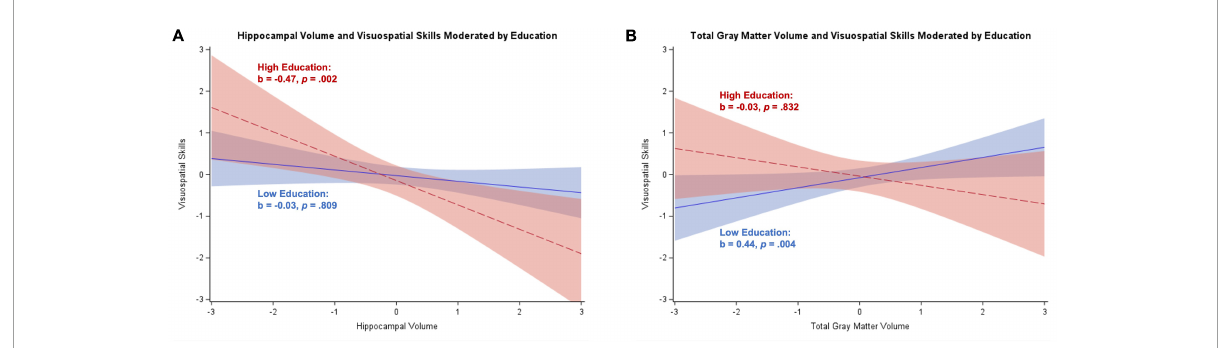
FIGURE2 Plots of significant moderations by education of the associations between brain volume and visuospatial skills for participants with dementia. High education corresponds to 1 SD above the mean and low education corresponds to 1 SD below the mean. The red dotted line represents high education, and the blue solid line represents low education. Shaded areas represent 95% confidence intervals. Visuospatial skills and brain volume were standardized. (A) Significant negative relationship between hippocampal volume and visuospatial skills for individuals with high education; non-significant for low education. (B) Significant positive association between total gray matter volume and visuospatial skills for participants with low education; non-significant negative association for individuals with high education.